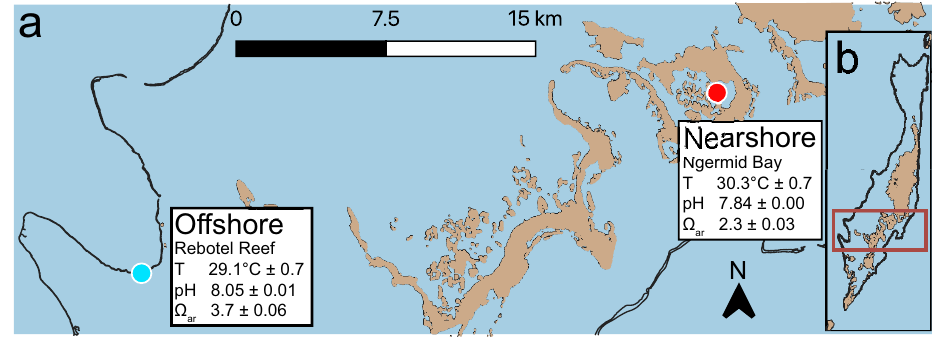
Figure 1. Map of study sites where coral colonies were collected in Palau, western Pacific. Land masses are presented in tan, seawater in blue, and offshore barrier reefs by black contours. ( a ) The nearshore (Ngermid Bay) and offshore (Rebotel Reef) site are represented with a red and blue circle, respectively. ( b ) The main islands of the Republic of Palau. Site parameters (temperature, pH, and Ω ar ) were incorporated from Shamberger et al. 31 and Barkely et al 30 . Maps were made using QGIS 3.28.1-Firenze (https:// qgis. org/ en/ site/) from data